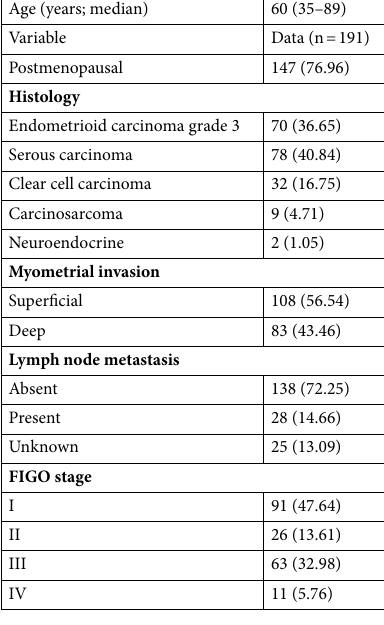
Table 1. Patients’ characteristics. Numbers in parentheses are percentages.